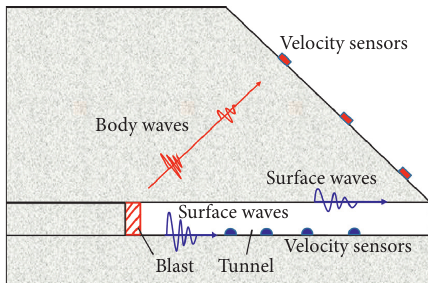
Figure 1: Schematic diagram of seismic wave propagation and vibration monitoring for tunnel